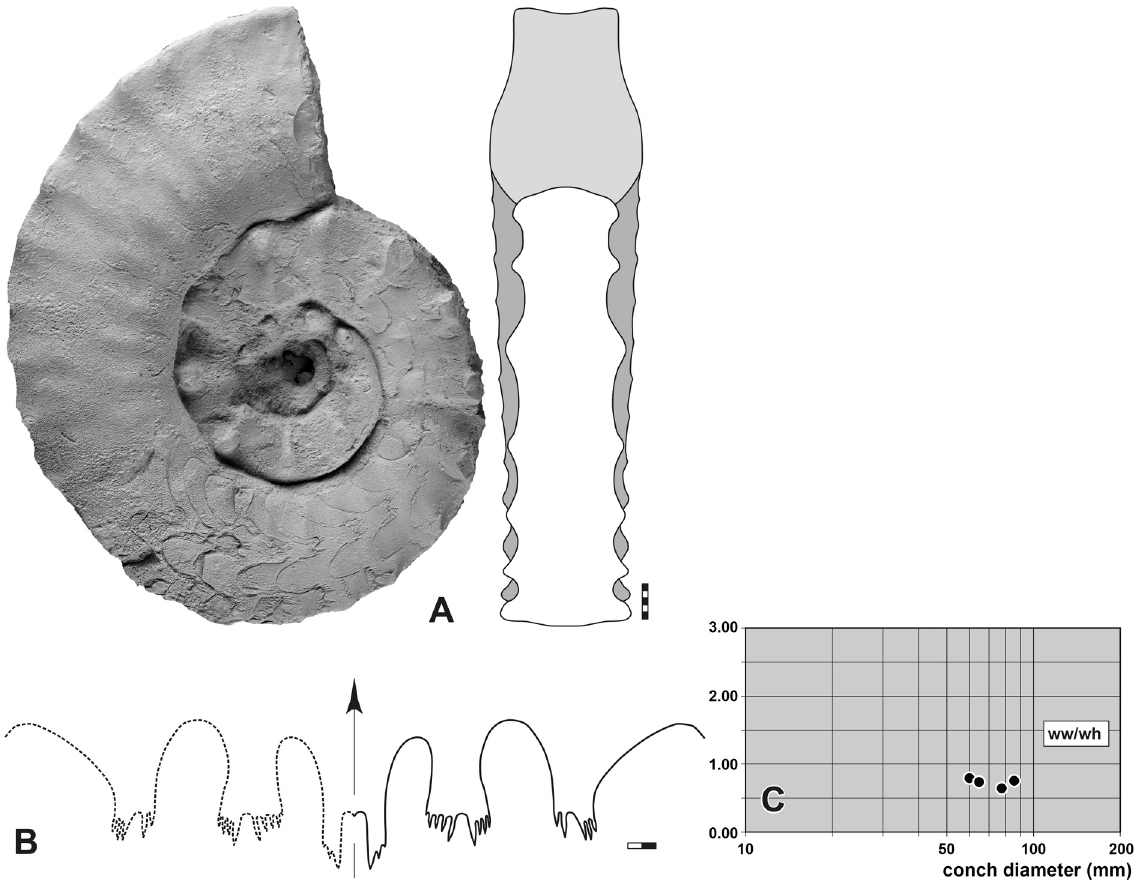
Fig. 53. Lutites profundus Korn & Hairapetian gen. et sp. nov. A . Lateral and dorsal view,